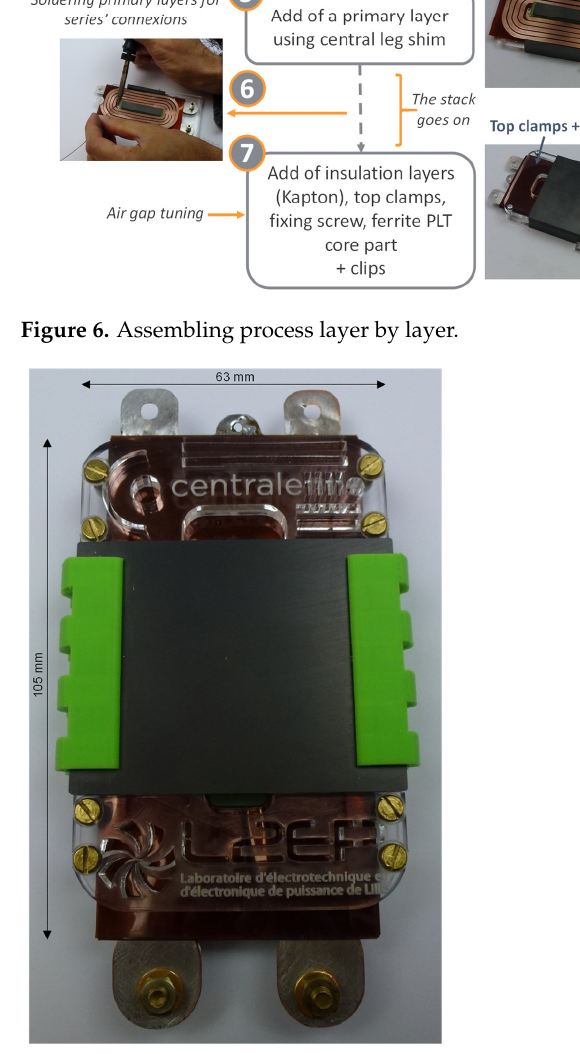
Figure 7. Planar transformer prototype.